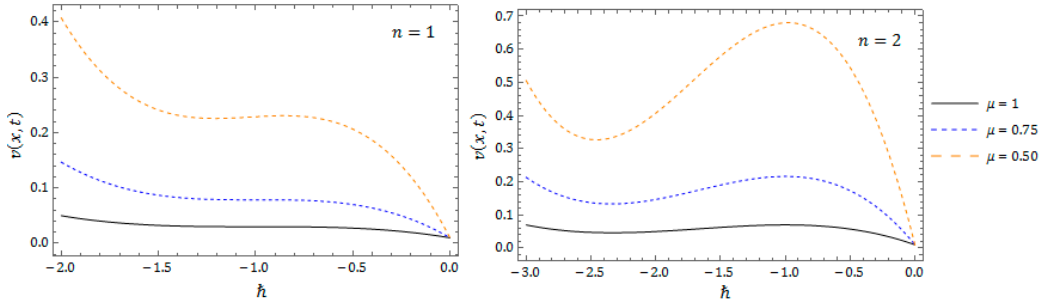
Figure 5 . ℏ -curves obtained for 𝑣(𝑥,𝑡) in case (𝑖𝑖) with diverse 𝜇 when 𝑥 = 0.1 and 𝑡 = 0.01 at distinct 𝑛 . Figure 5. (cid:125) -curves obtained for v ( x , t ) in case ( ii ) with diverse µ when x = 0.1 and t = 0.01 at distinct n . In order to show the efficiency of the proposed technique for case (𝑖𝑖) , the numerical Table 2. Numerical simulations for the FKPP equation considered in case ( ii ) using q -HATM at (cid:125) = − 1 simulations have been connected, which are presented in Table 2 . and n = 1 with distinct x and t for different µ Table 2 Numerical simulations for the 𝐹𝐾𝑃𝑃 equation considered in case (𝑖𝑖) using 𝑞 -HATM at ℏ = −1 and 𝑛 = 1 with distinct 𝑥 and 𝑡 for different 𝜇.